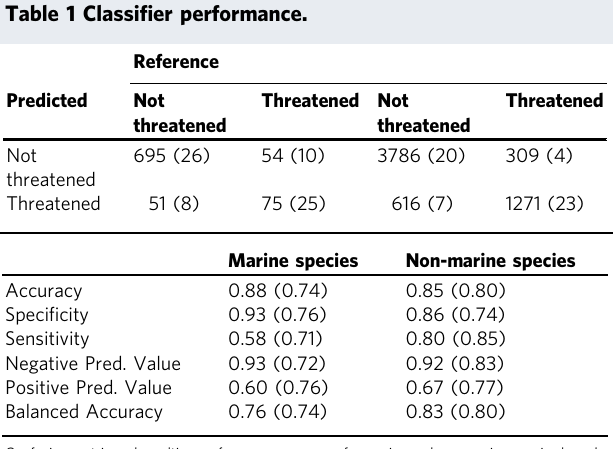
Table 1 Classi fi er